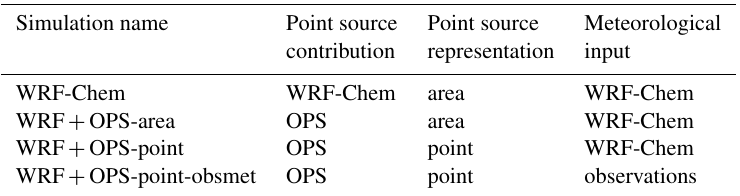
Table 2. Overview of the simulations, which model is used to calculate the urban plume mixing ratio from point sources in the Rijnmond area, how point sources are represented and the source of meteorological